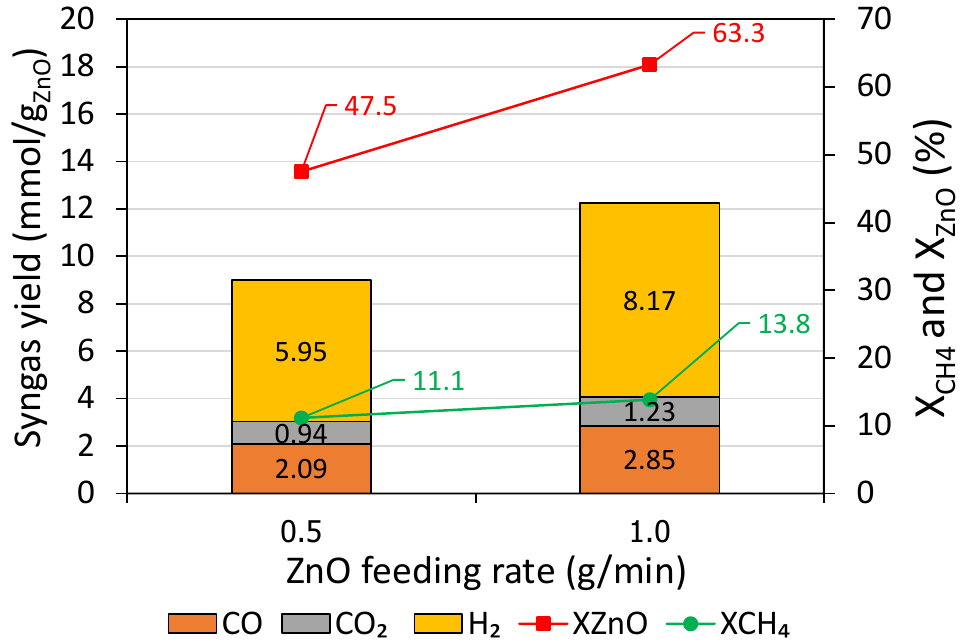
Figure 5. Syngas yield, methane conversion (X CH4 ), and net ZnO conversion (X ZnO ) as a function of ZnO feeding rate at 950 °C and atmospheric pressure. Source: author.